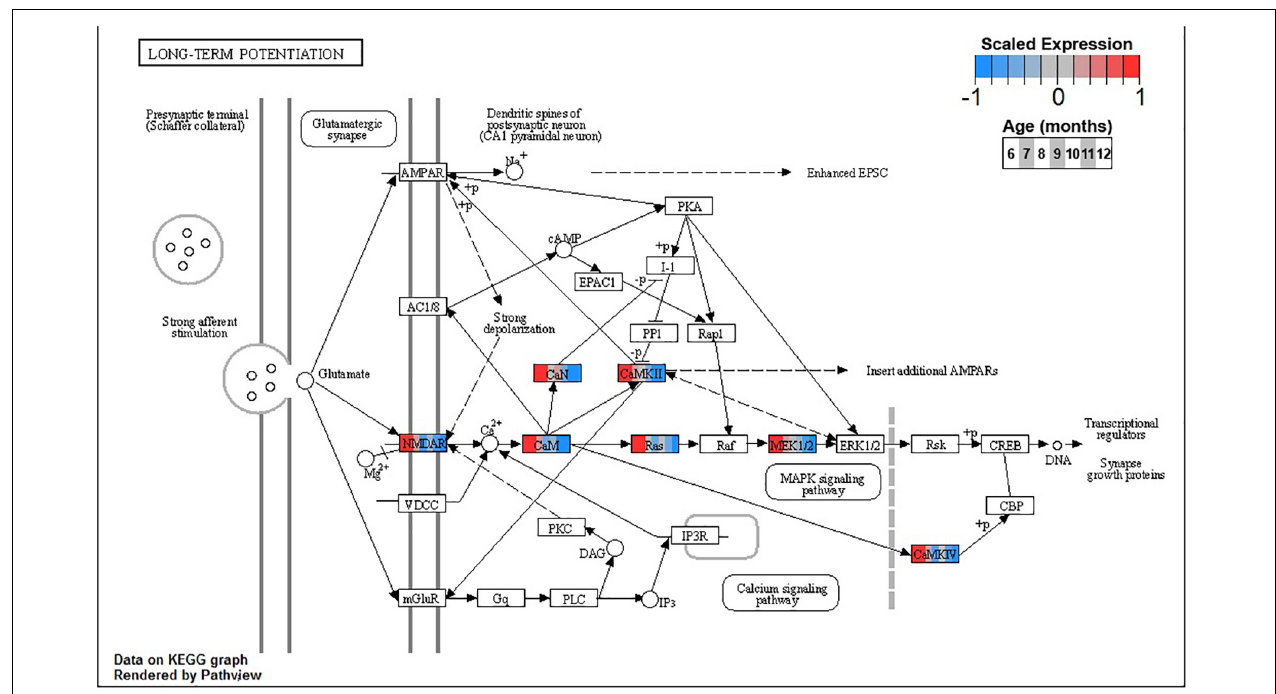
FIGURE 7 | Expression of orthologs annotated for the Kyoto Encyclopedia of Genes and Genomes (KEGG) long-term potentiation (ko04720) pathway present in pleural ventral caudal sensory neuron (PVC) expression clusters with decreasing trend (P4 and P5). Each node of the pathway diagram represents an ortholog assigned to an Aplysia californica transcript. Nodes are divided into seven colored sections, from left to right, ages 6 to 12 months. Node sections are colored according to their mean centered and variance scaled expression, together representing the expression trends of each node across the aging process. Nodes that are not colored were absent from the gene sets of expression clusters P4 and P5. Pathway enrichment demonstrates broad downregulation of key signaling cascades in